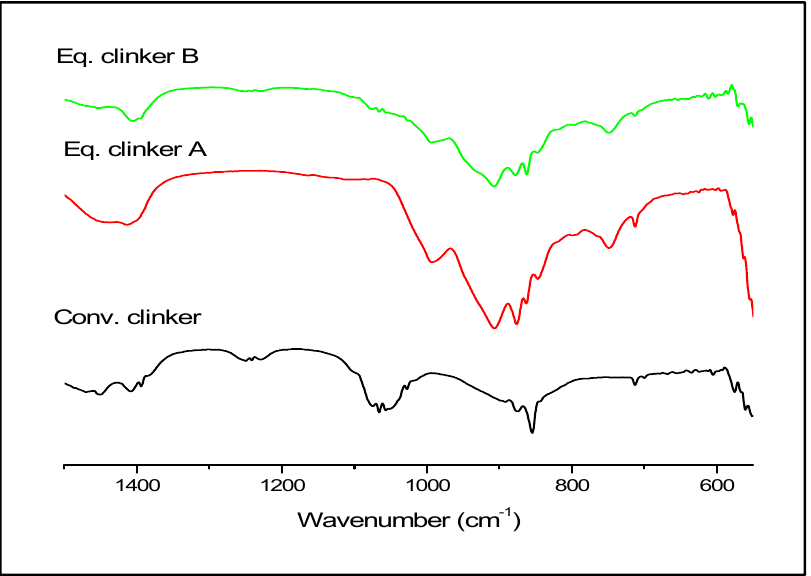
Figure 9. X-ray diffraction patterns of clinker A and B produced by mechanosynthesis versus conventional clinker.